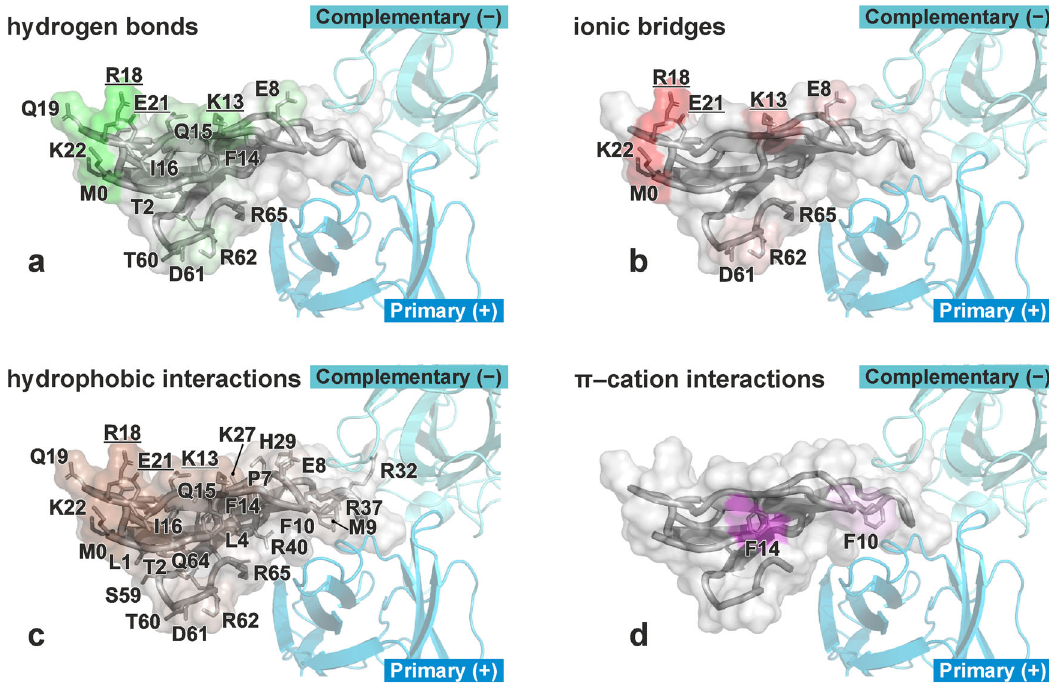
Fig. 5 Details of toxin/lipid interactions in α 7-nAChR/WTX complex in membrane environment. a – d show WTX in surface representation viewed from “ below ” (from the membrane side, see green arrow in Fig. 4d), colored according to an intensity of interaction with the lipids ( a — hydrogen bonds; b — ionic bridges and ion – dipole interactions; c — hydrophobic interactions; d — π – cation interactions). Primary ( + ) and complementary ( − ) subunits of α 7-ECD are shown. TM-domain of α 7-nAChR and lipids are omitted for clarity. WTX residues mutated in this work are